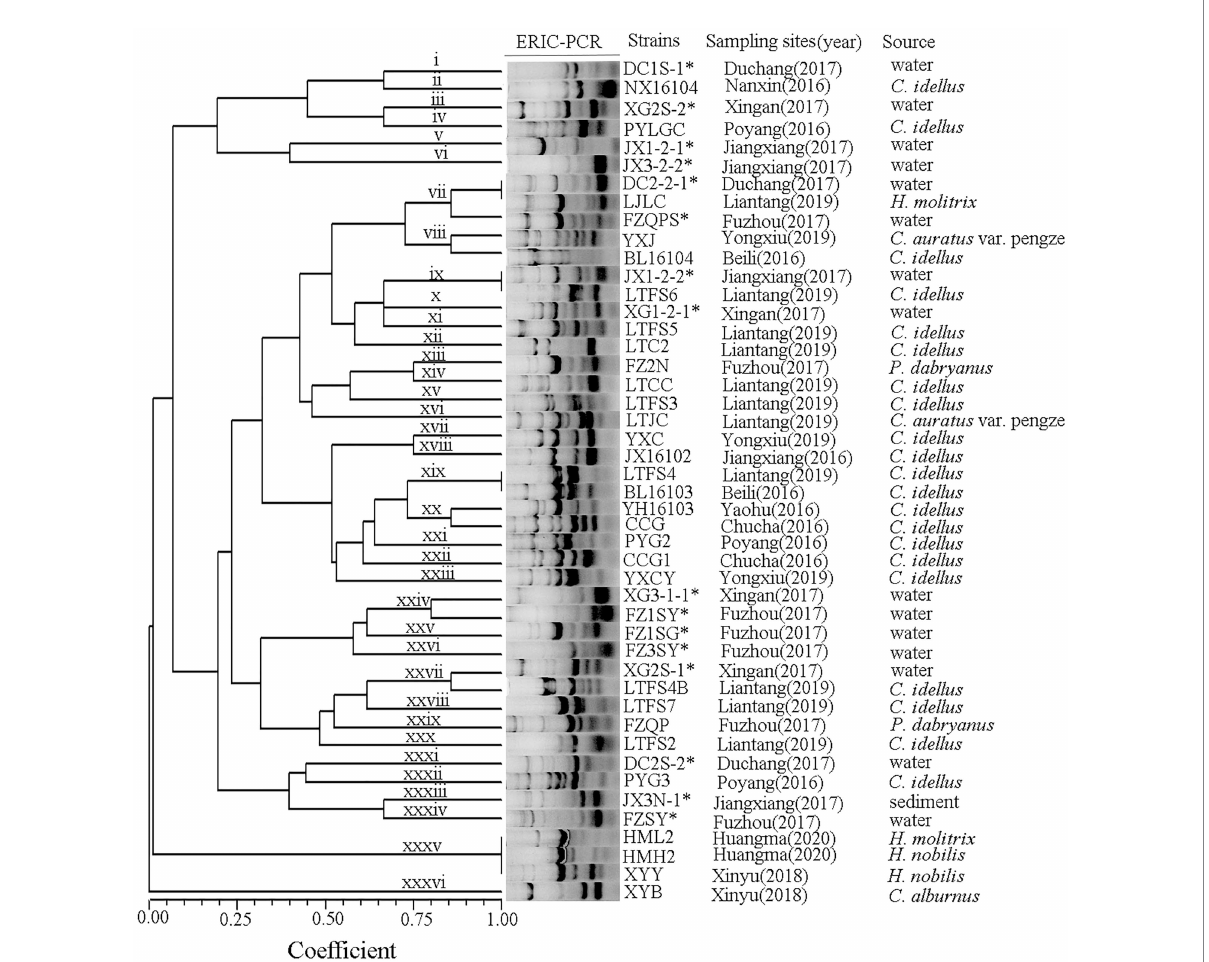
FIGURE 2 Dendrogram showing the ERIC profiles of the A. veronii isolates used in this study. “*“indicated the strains isolated from pond water or sediment (the same